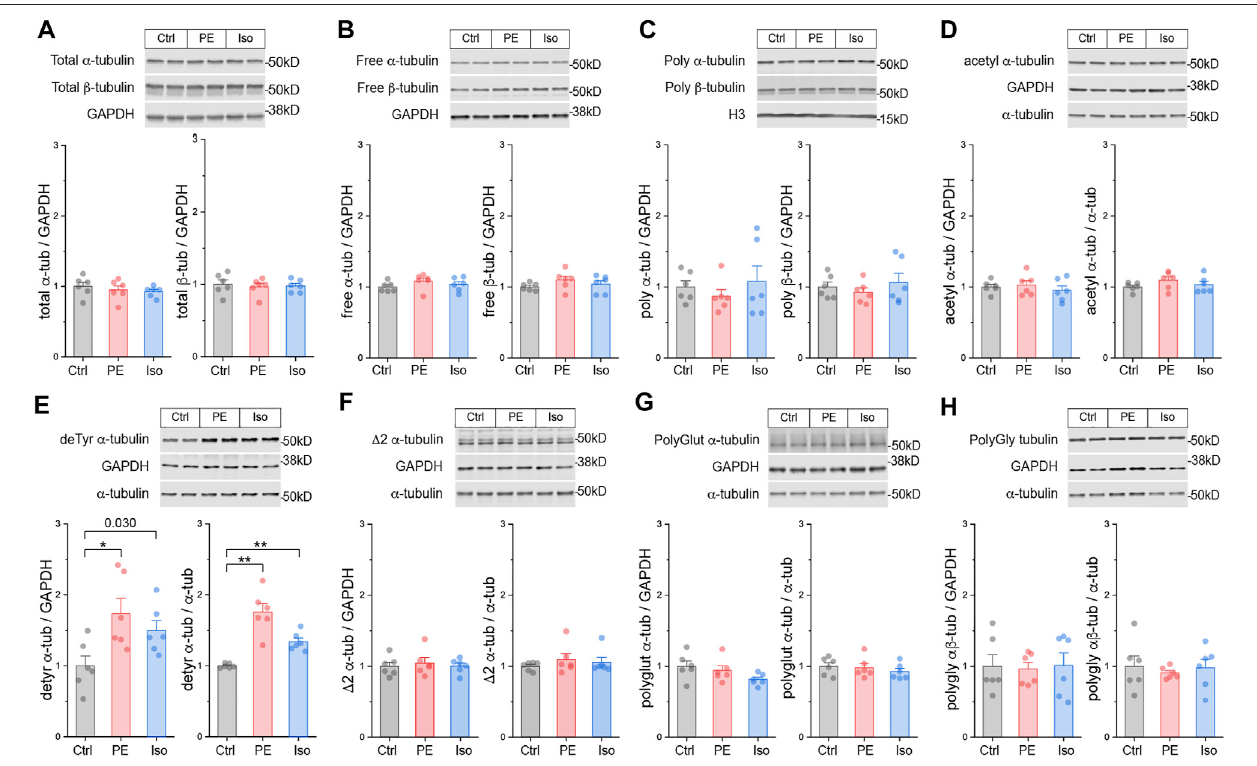
FIGURE 3 | The microtubule network is rapidly detyrosinated upon hypertrophic stimulation. Representative immunblots and relative fold-change of α -tubulin (left) and β -tubulin (right)in (A) totalproteins, (B) freeor (C) polymerized -tubulin fractions ( n = 6).Representative immunoblotswithtechnical duplicate lanes and relative fold- changeusingGAPDH(left)or α -tubulin(right)asloadingcontrolsfor (D) acetylated α -tubulin, (E) detyrosinated α -tubulin, (F) Δ 2 α -tubulin, (G) polyglutamylated α -tubulin, & (H) polyglycylated pan-tubulin ( n = 6). For all bar plots, whiskers represent + 1SEM and bar represents mean. For all graphs, * represents p-value from Welch- corrected two-tailed two-sample t-test < 0.025 (Bonferroni-corrected for two comparisons), ** represents p < 0.01, and *** represents p < 0.001.